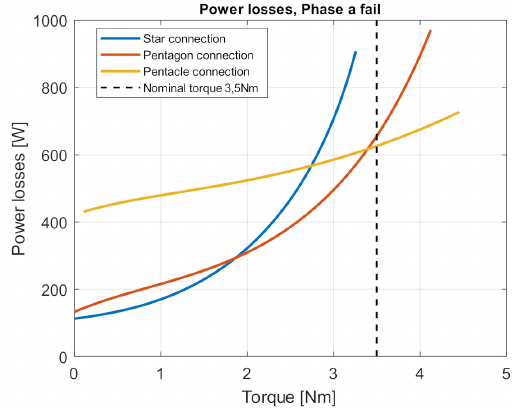
Figure 15. Motor losses, phase failure a, U IN = 5 × 230 V, 50 Hz.